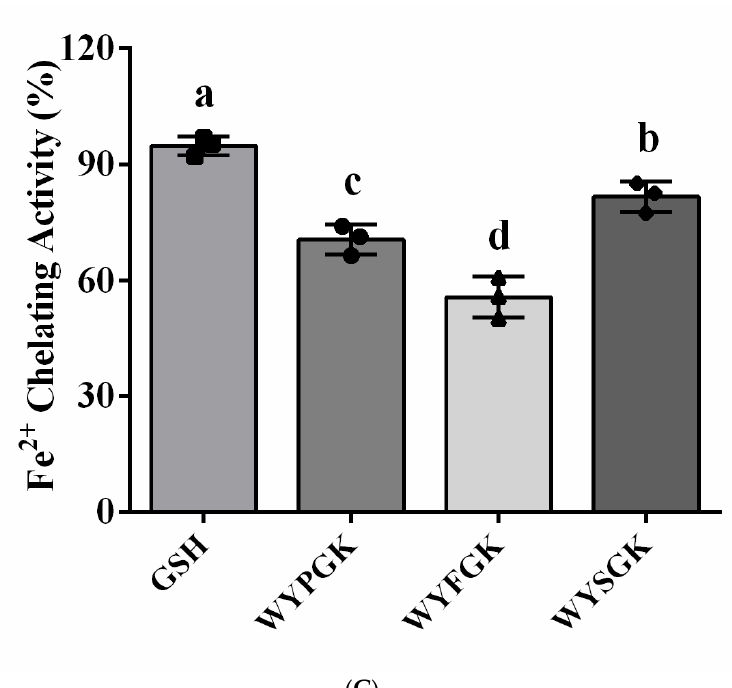
Figure 2. Antioxidant activity assay of WYPGK, WYFGK, and WYSGK. ( A ) ORAC assay; ( B ) ABTS radical scavenging activity; ( C ) Fe 2+ chelating activity. Data are presented as means ± SD from three replicates. Different letters denote statistically significant differences ( p < 0.05).